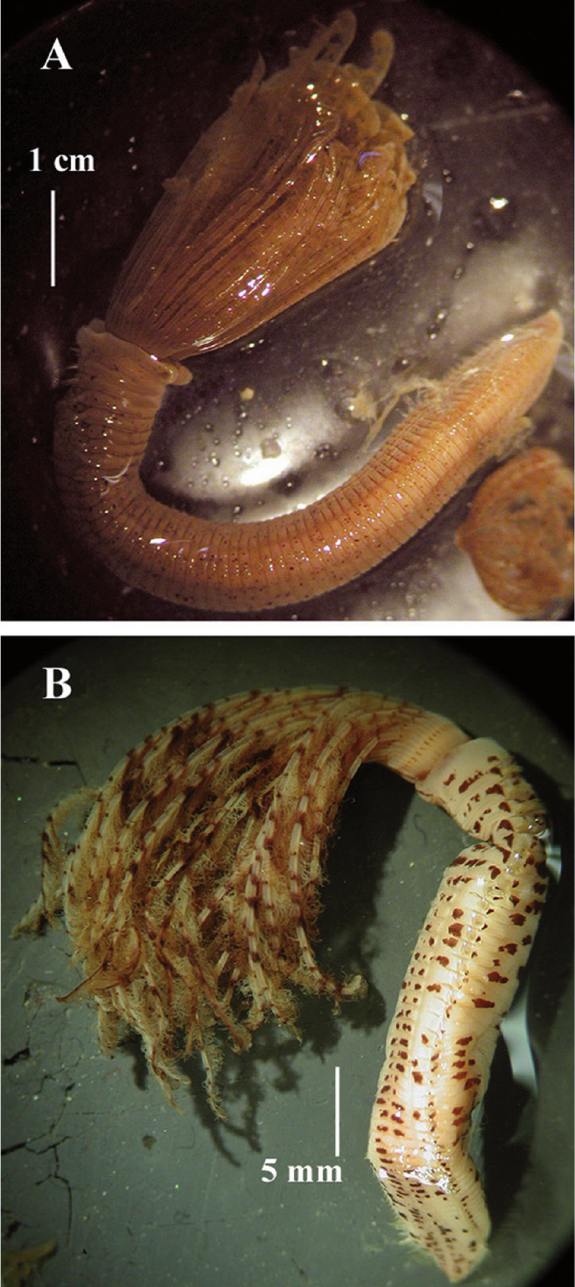
Fig . 4. – A, Branchiomma luctuosum ; B, Branchiomma